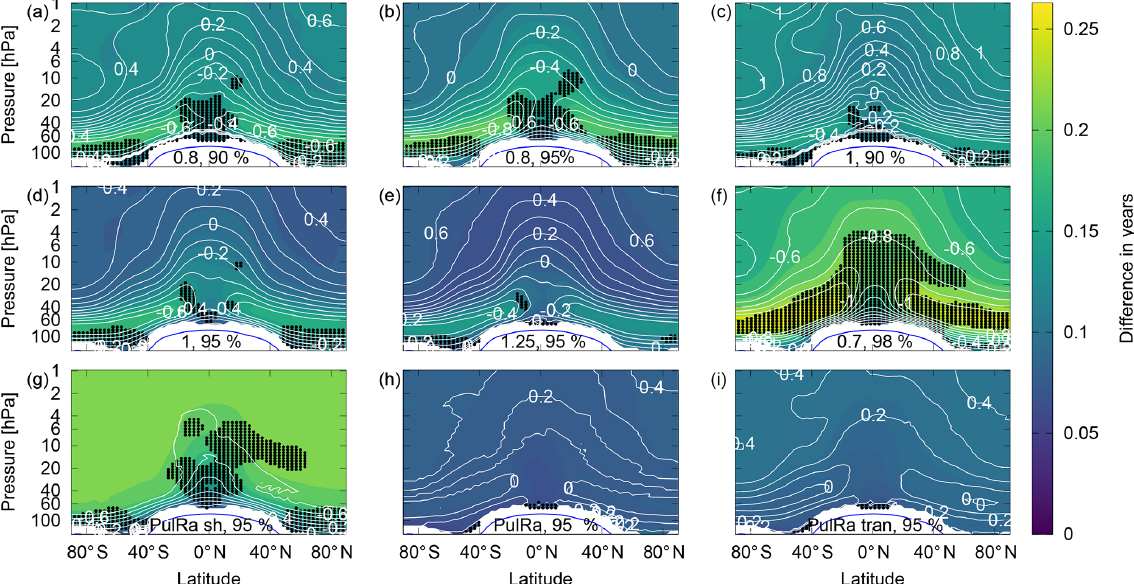
Figure 8. Mean absolute deviation of mean AoA calculated from SF 6 from AoA derived from an ideal tracer for a different ratio of moments and fraction of input (colours). The overlaid white contours are the difference in trends in 10 − 1 years per decade. At the bottom of each panel, the fraction of input and ratio of moments considered in the derivation are stated. PulRa denotes the ratio of moments derived from the tranPul simulation annual mean extended age spectra and PulRa sh is from the 9.5-year spectra. PulRa trans uses the transient extended spectra from that simulation. White areas indicate where the derivation is not applicable. Black stippling shows insignificance of the SF6 trend from zero on the 95% confidence level. The trend calculation considered the time series from 1975 to 2011. The tropopause and the range 30K above are excluded, as the AoA calculation is not defined in this region due to the different entry regions into the stratosphere that have to be considered.